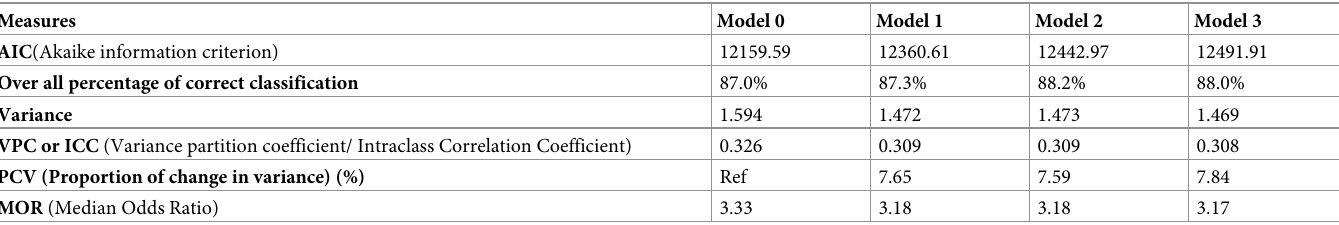
Table 4. Measure of variation on individual and community level factors among health facility delivered mothers in Ethiopia, EDHS 2016 dataset.